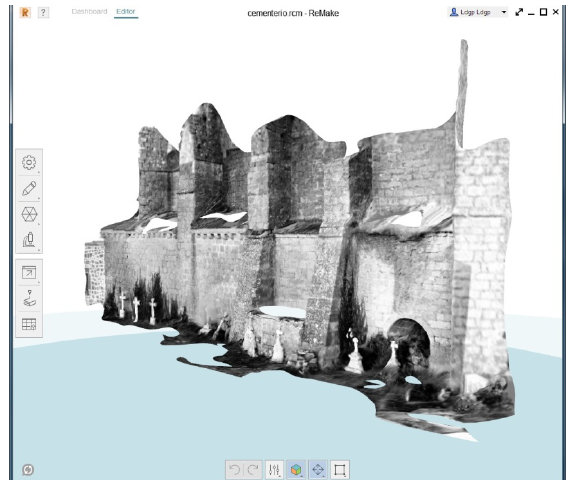
Figure 8. Virtual model from the collection of images of the graveyard, using the software Autodesk